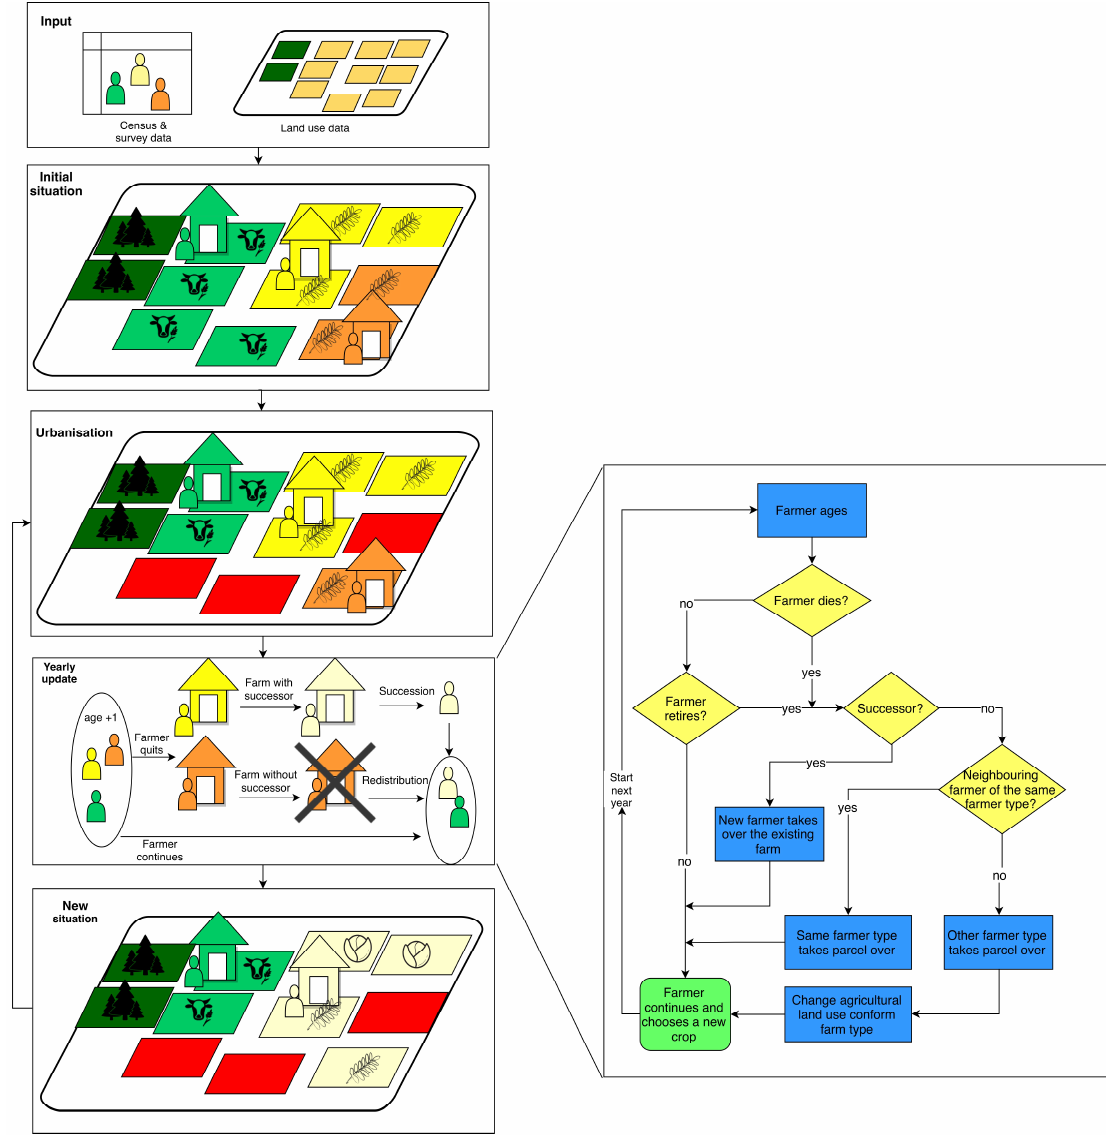
Figure 1. Overview of the Agricultural Dynamics through Agent-based Modelling (ADAM) model. Table 1. Overview of the different variables representing the characteristics of farms and farmers in the